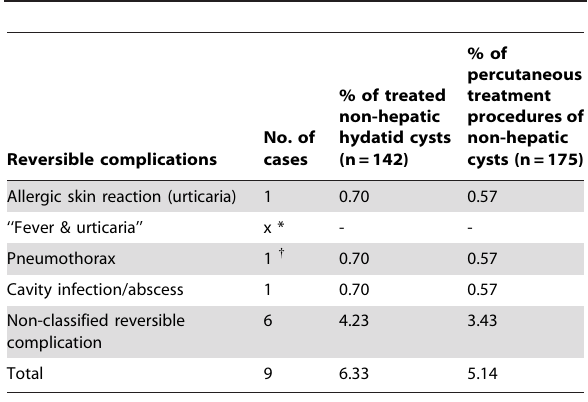
Table 6. Overall reversible complications due to percutaneous treatment of hydatid